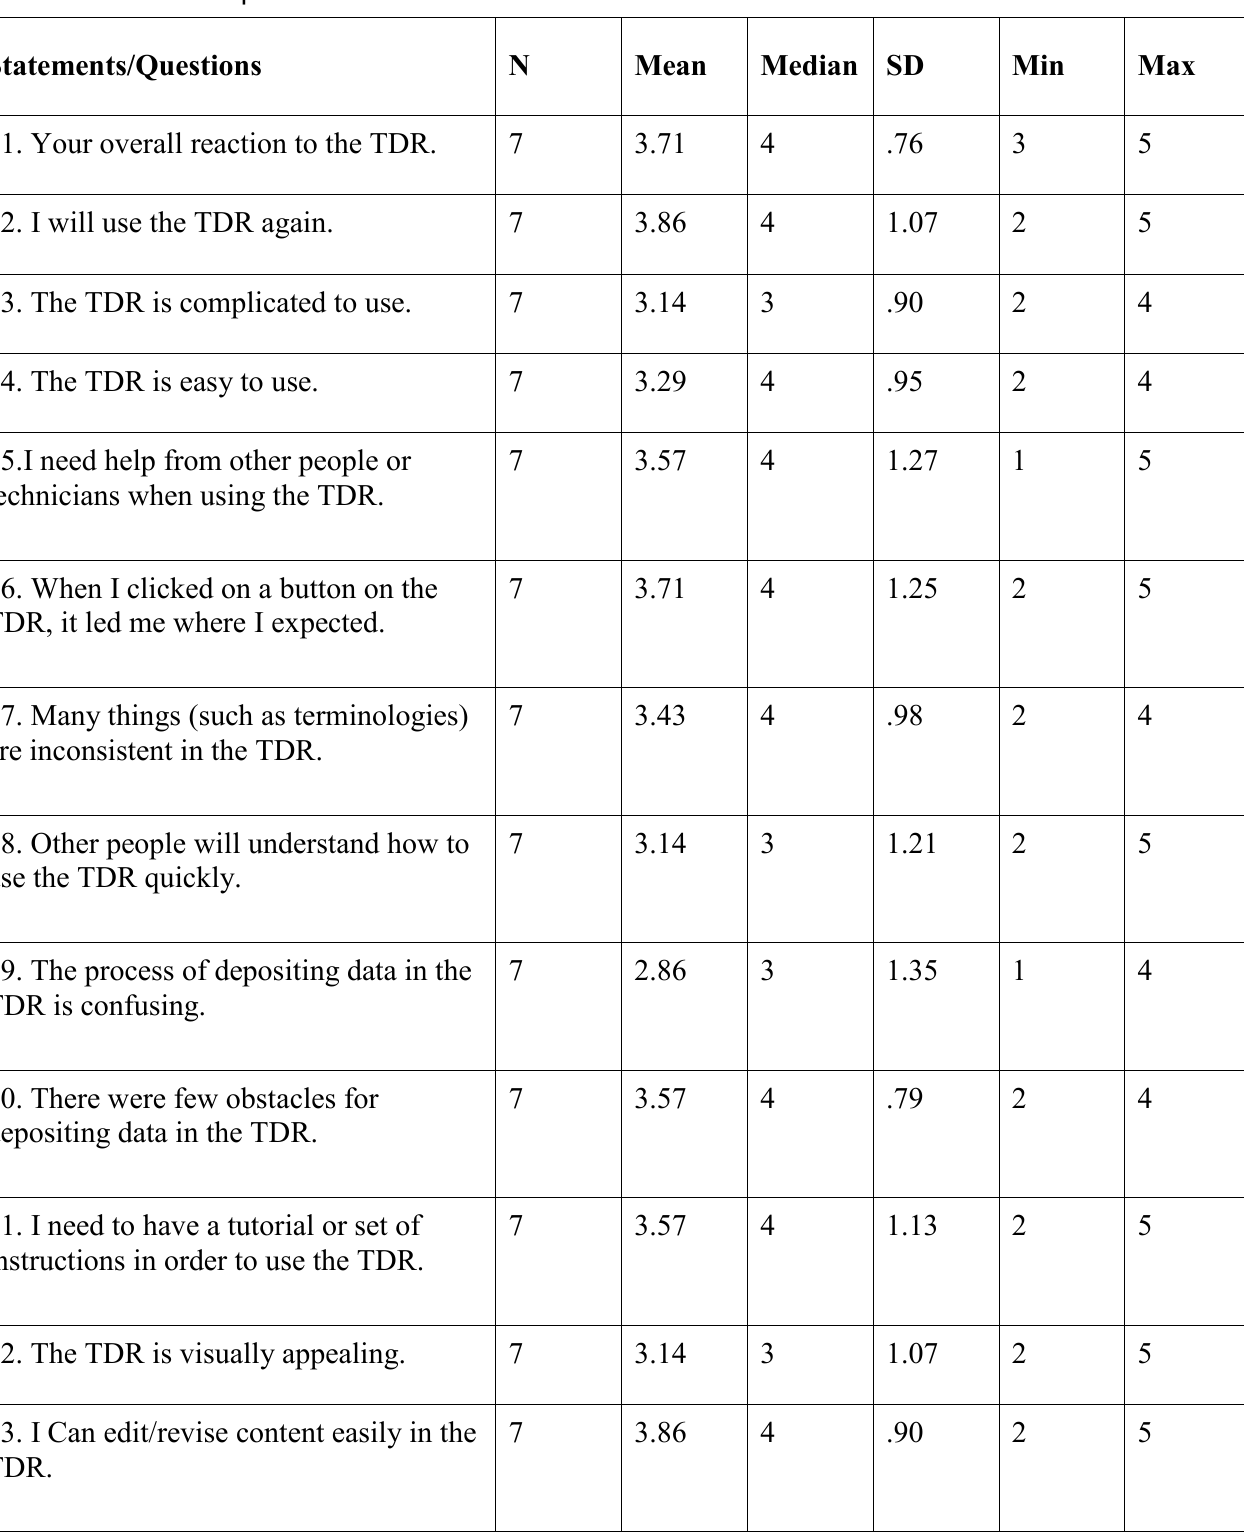
Table 2 : Exit questionnaire results